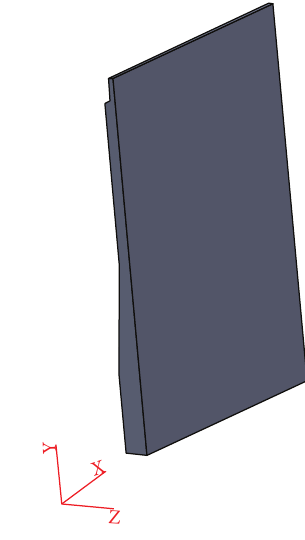
Figure 11: Computational domain of weir for flow uniformity.